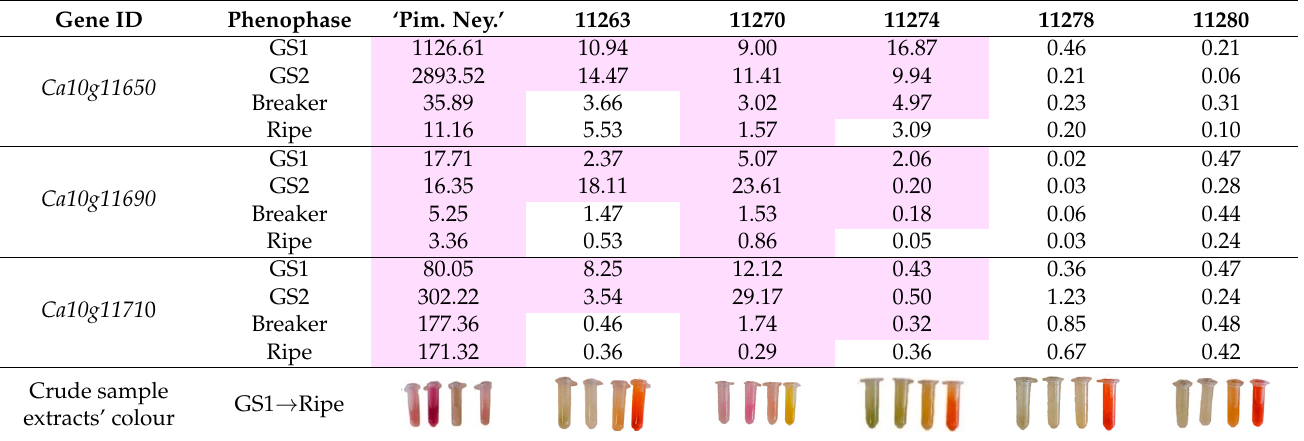
Figure 2. Fold expression pattern of the tested genotypes compared to cv. ‘Soroksári’ in 4 phenopha- ses, pseudo-colour bar is showing the level of fold expression on a normalized scale. Table 6. Log2 fold change of R2R3-MYBs compared to the cv. ‘Soroksári’ and extracts’ colouration throughout the four tested phenophases.